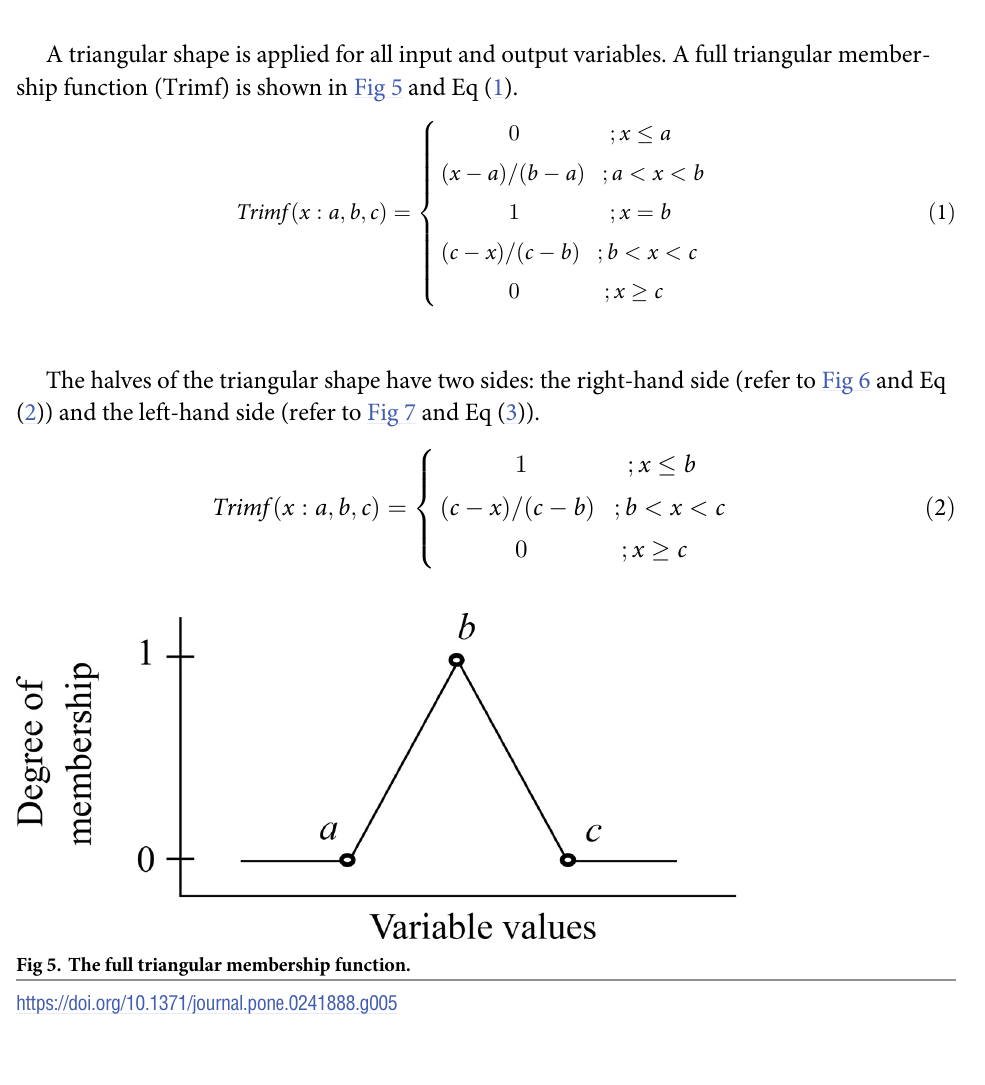
Fig 4. A fuzzy controller scheme of DY and SY classification. The links between four modules comprising a fuzzy controller, including a fuzzy rule base , a fuzzy inference engine , and fuzzification/defuzzification .